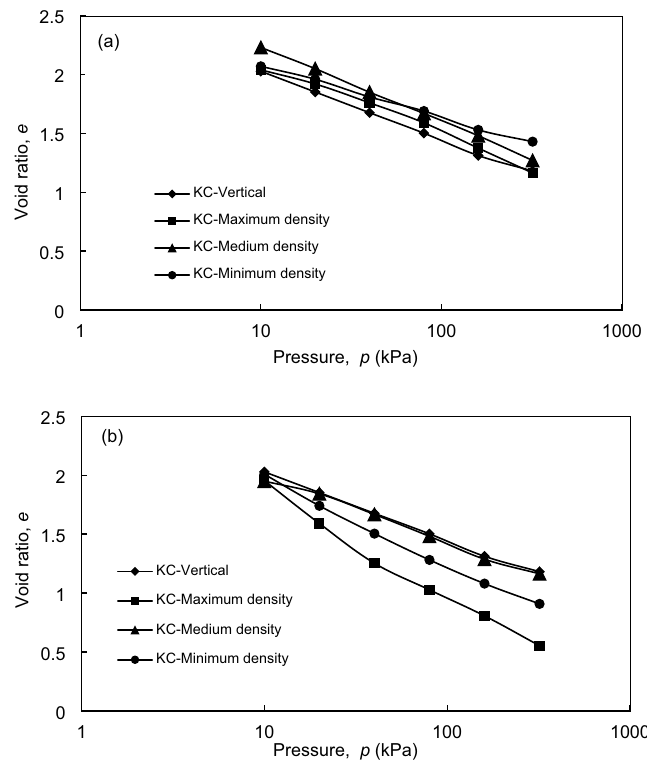
Fig. 5 e log p curve with vertical and radial drainage using a RHA, b FA drain at various densities for